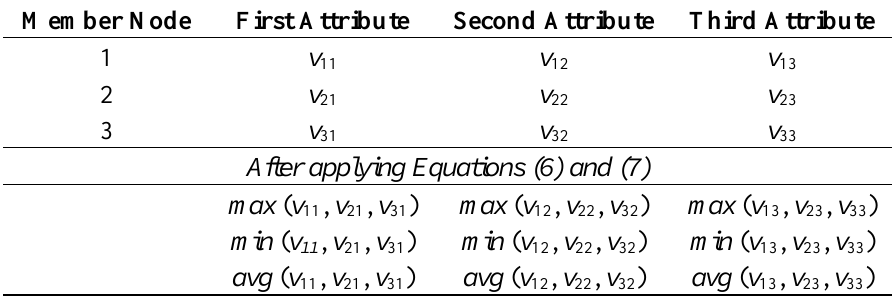
Table 2. Illustration of Equations (6) and (7).